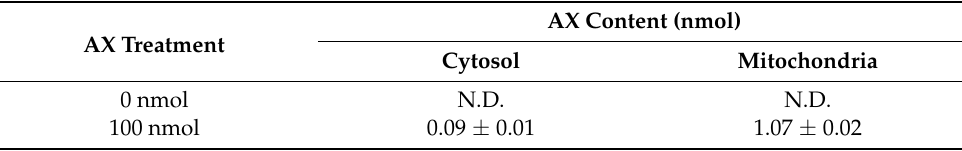
Table 1. AX content in mitochondria and cytosol of AX-treated Sol8 myotubes.